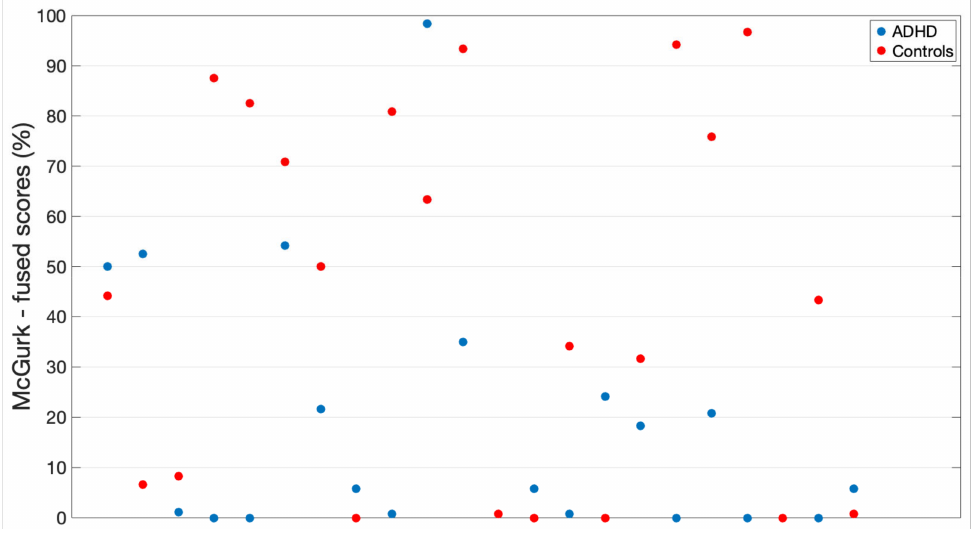
Figure 1. McGurk performance: percentage of successful fused